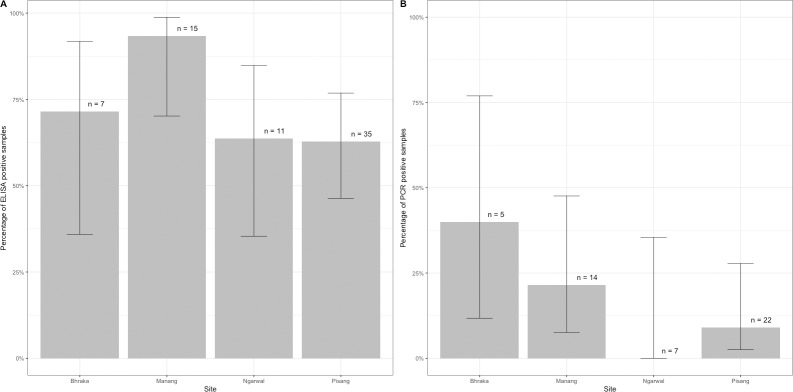
(A) Percentage of ELISA-positive and (B) PCR-positive dogs at each site, and 95% confidence intervals. Only samples that were ELISA-positive, and which had sufficient blood, were analysed for P-gene with PCR.